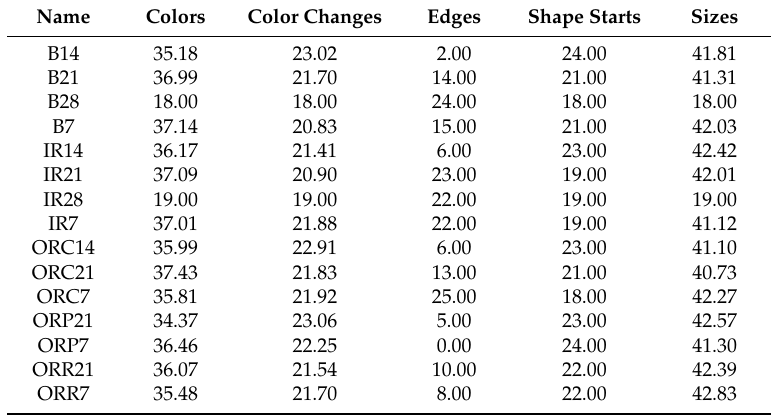
Figure 19. VNS-clustering for CWR Bearing Data Center (Outer race opposite 21” failure). Table 4. CMO-Learning knowledge base for CWR bearing data center learning datasets.